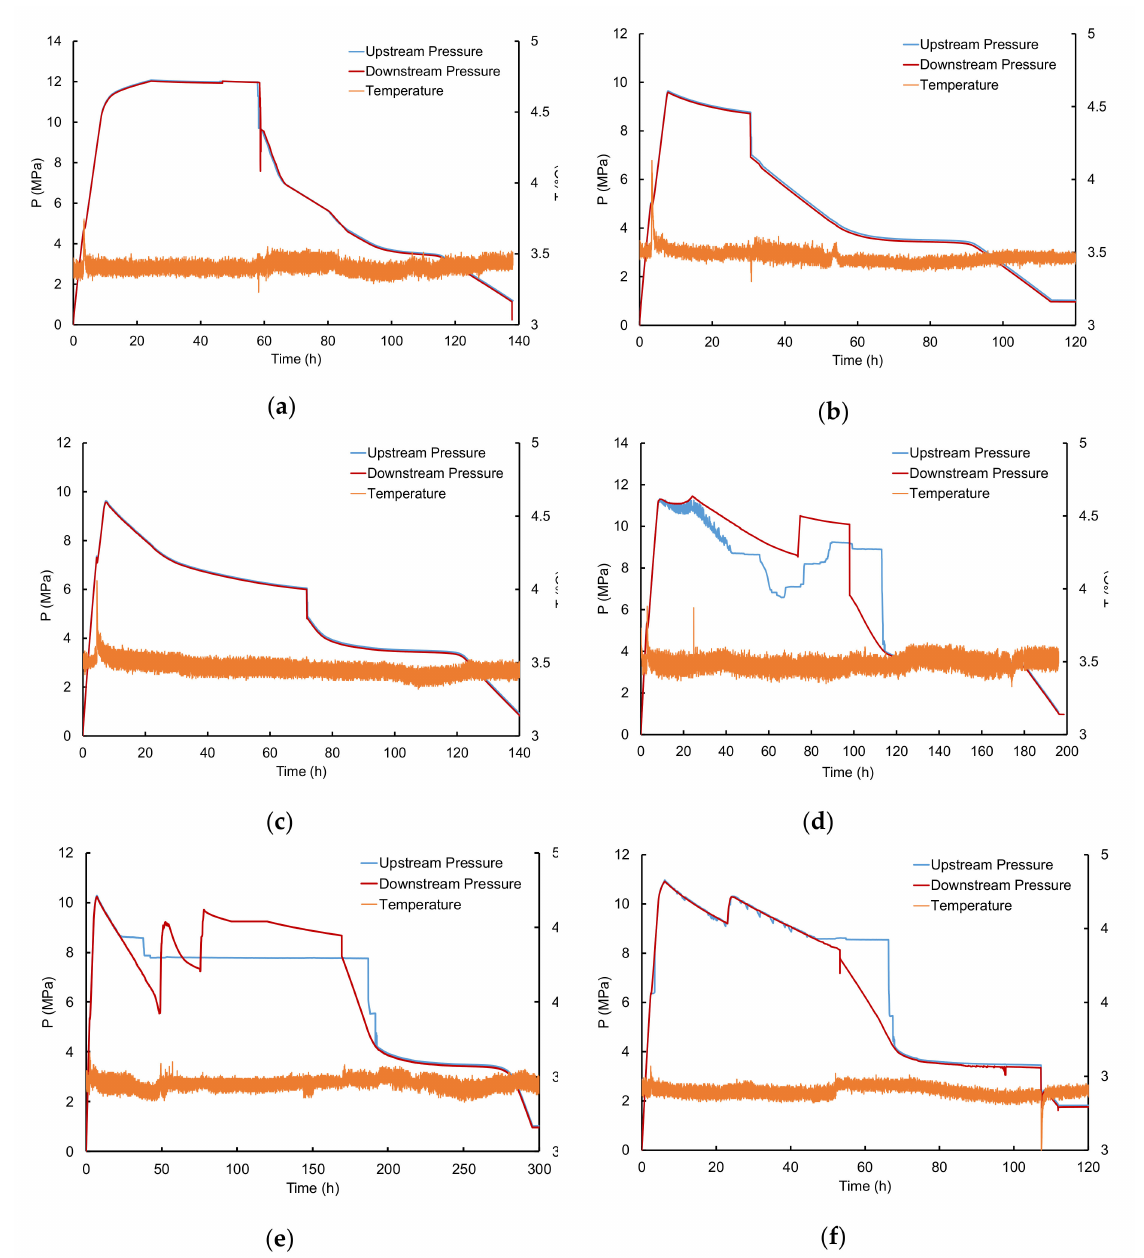
Figure 7. Upstream and downstream pressure and temperature profiles for experiments with non-sieved sand, a gas flowrate around 58 mLn · min − 1 and di ff erent water saturations S w : ( a ) S w = 10.8%; ( b ) S w = 21.6%; ( c ) S w = 33%; ( d ) S w = 44%; ( e ) S w = 55%; ( f ) S w = 66.3%. During the hydrate formation step, methane is continuously injected into the high-pressure cell until the system pressure reaches the cylinder pressure (~10.5–11 MPa), and then, the injection is stopped. However, during this period of no-methane injection, the hydrate formation continues within the cell, with methane gas consumption and a decrease of the cell pressure. Consequently, the pressure balance between the gas cylinder and the high-pressure cell is breaking, the methane injection resumes and the cell pressure increases again. This switch between balance and unbalance between the cylinder and the cell pressure explains the up and down oscillations observed between 10–25 h on the upstream pressure in Figure 7d–f. Thereafter, the gas injection is definitely stopped by closing the inlet valve of the